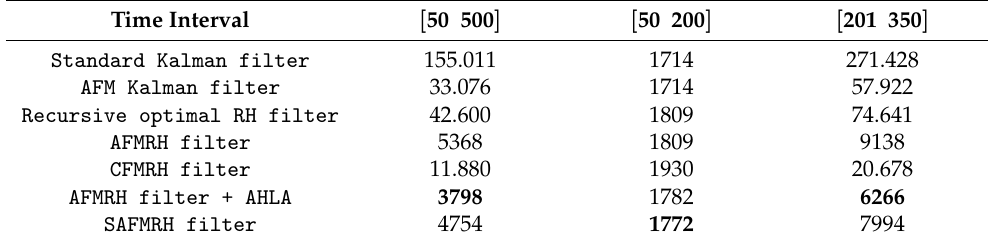
Figure 6. Estimation errors of filters. Table 1. RMSE errors ( × 10 − 2 ◦ C )